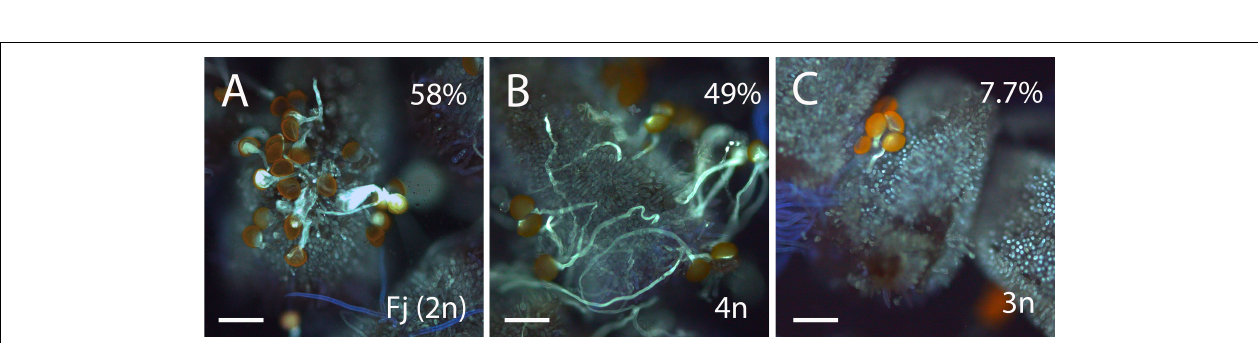
FIGURE 4 | Aniline-blue-stained squash mounts of stigmas of Annona cherimola showing germination of pollen from diploid A. cherimola , cv. Fino de Jete “Fj” (A) , tetraploid (B), and triploid (C) hybrid. Scale bars, 100 µ m.